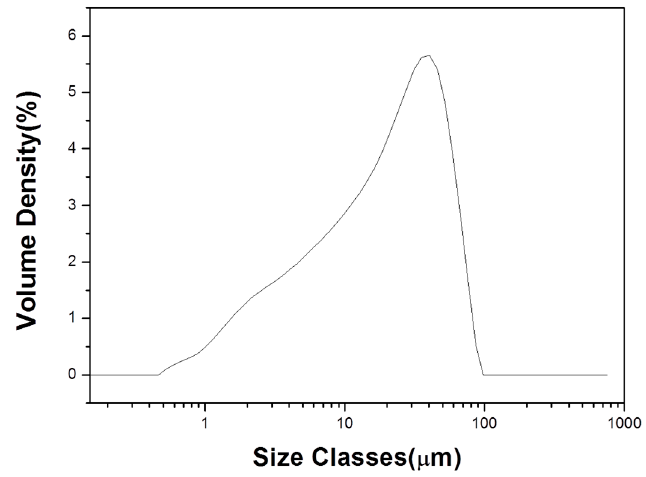
Figure 3. Thermogravimetry-differential thermal Analysis ( TG-DTA) results of acid clay.